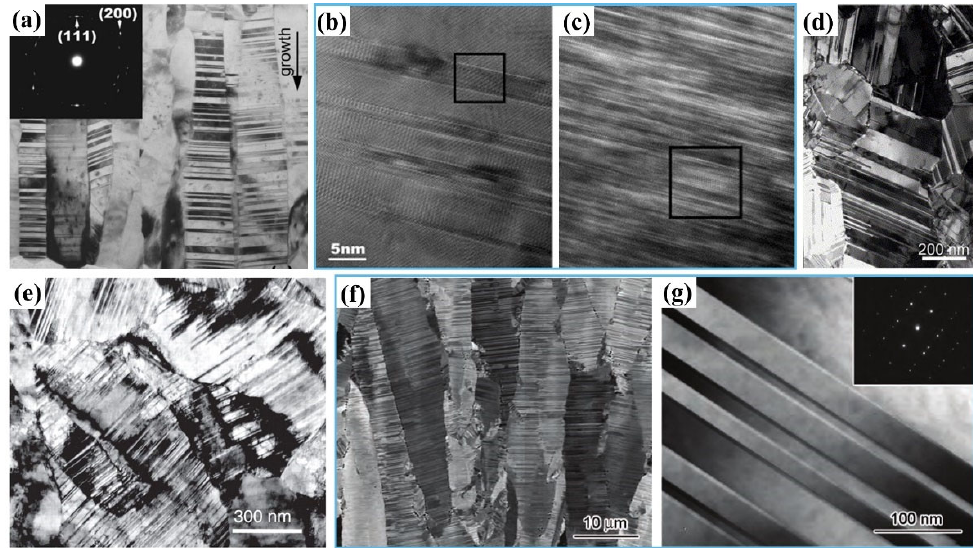
Figure 4. ( a ) TEM micrograph of Cu foils with NT structure by magnetron sputtering [70]; ( b ) high- resolution TEM (HRTEM) image of nanotwins in Cu (regular nanoscale twins are shown in the black square) [101]; ( c ) HRTEM image of twins in 330 SS (extremely fine scale twins are shown in the black square) [101]; ( d ) TEM image of NT Cu prepared by pulsed electrodeposition with λ of 15 nm at current density of 70 mA/cm 2 [102] and ( e ) 4 nm at current density of 300 mA/cm 2 [60]; ( f ) SEM image of direct current electrodeposited NT Cu [103]; ( g ) TEM image of NT Cu and the SAED pattern (the inset) [103].